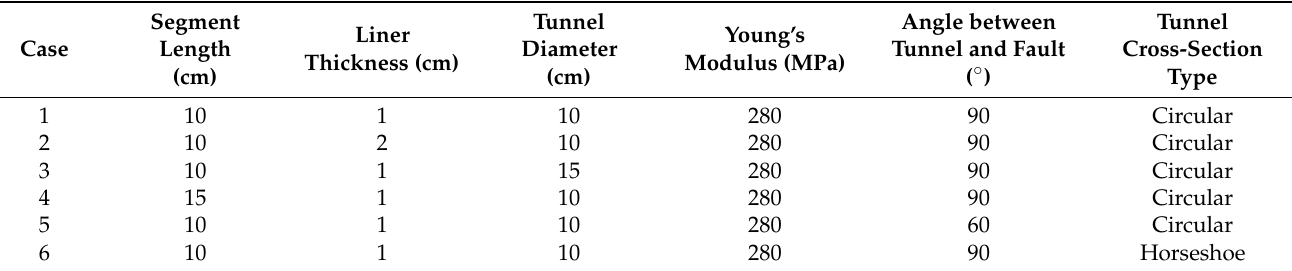
Table 4. Cases of Model Tests for ‘Articulated Design’.